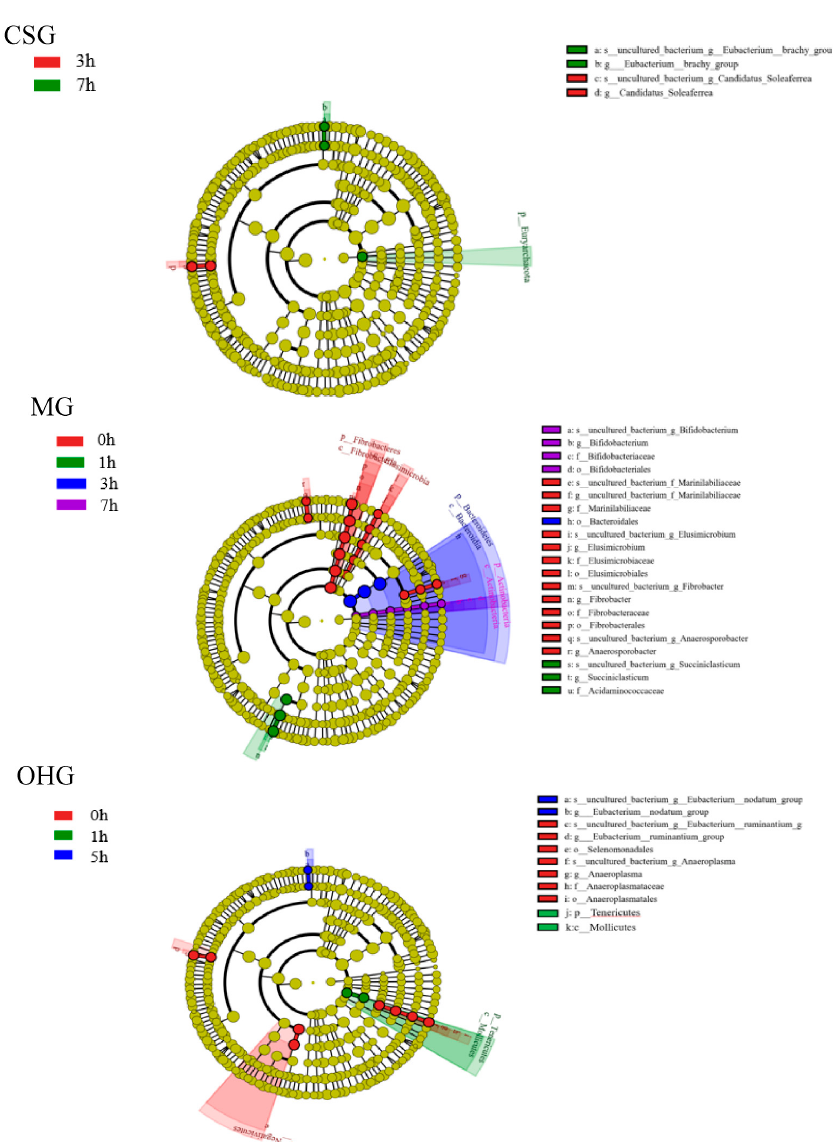
Figure 6. Linear discriminant analysis of e ff ect size (LEfSe) was used to identify significant di ff erences between bacterial groups in the same group at di ff erent times.